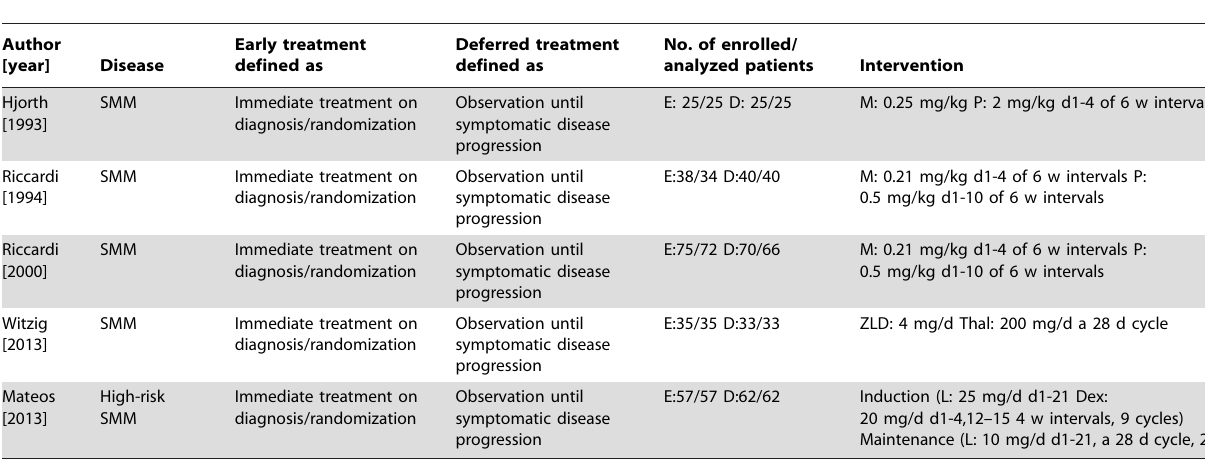
4 Progression In the early and deferred treatment arms, 198 and 201 patients were evaluable for disease progression, respectively. Twenty-seven (27) patients progressed to MM in the early treatment arm compared to 108 in the deferred treatment arm. As shown in Figure 3, there was a markedly reduced risk of disease progression with early treatment (pooled OR = 0.13, 95%CI= 0.07 to 0.24).